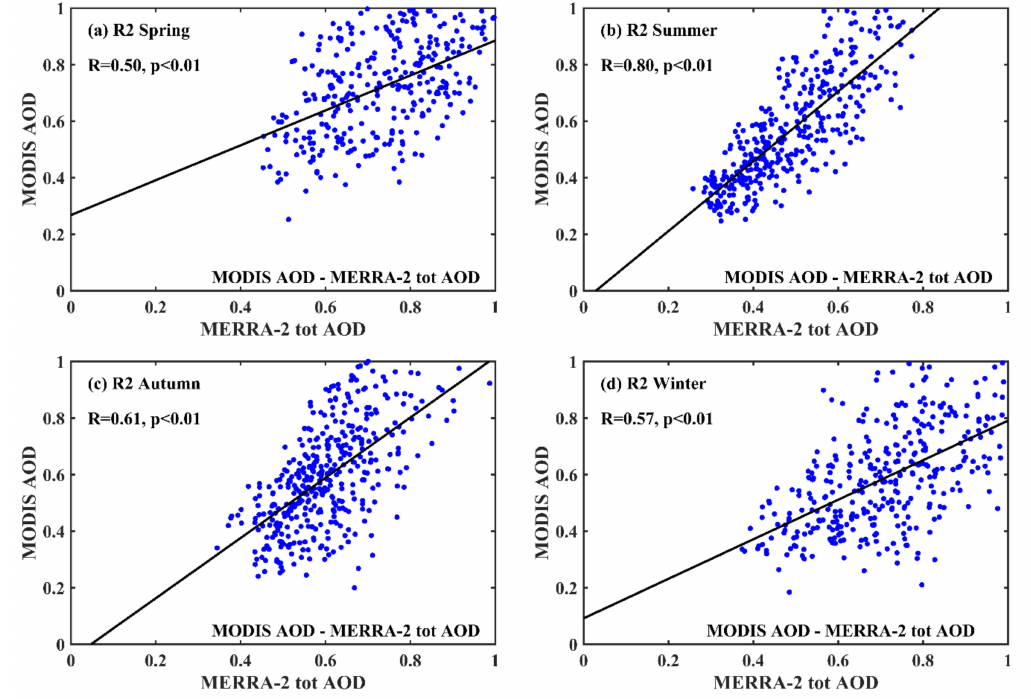
Figure A2. Same as in Figure A1 , but for